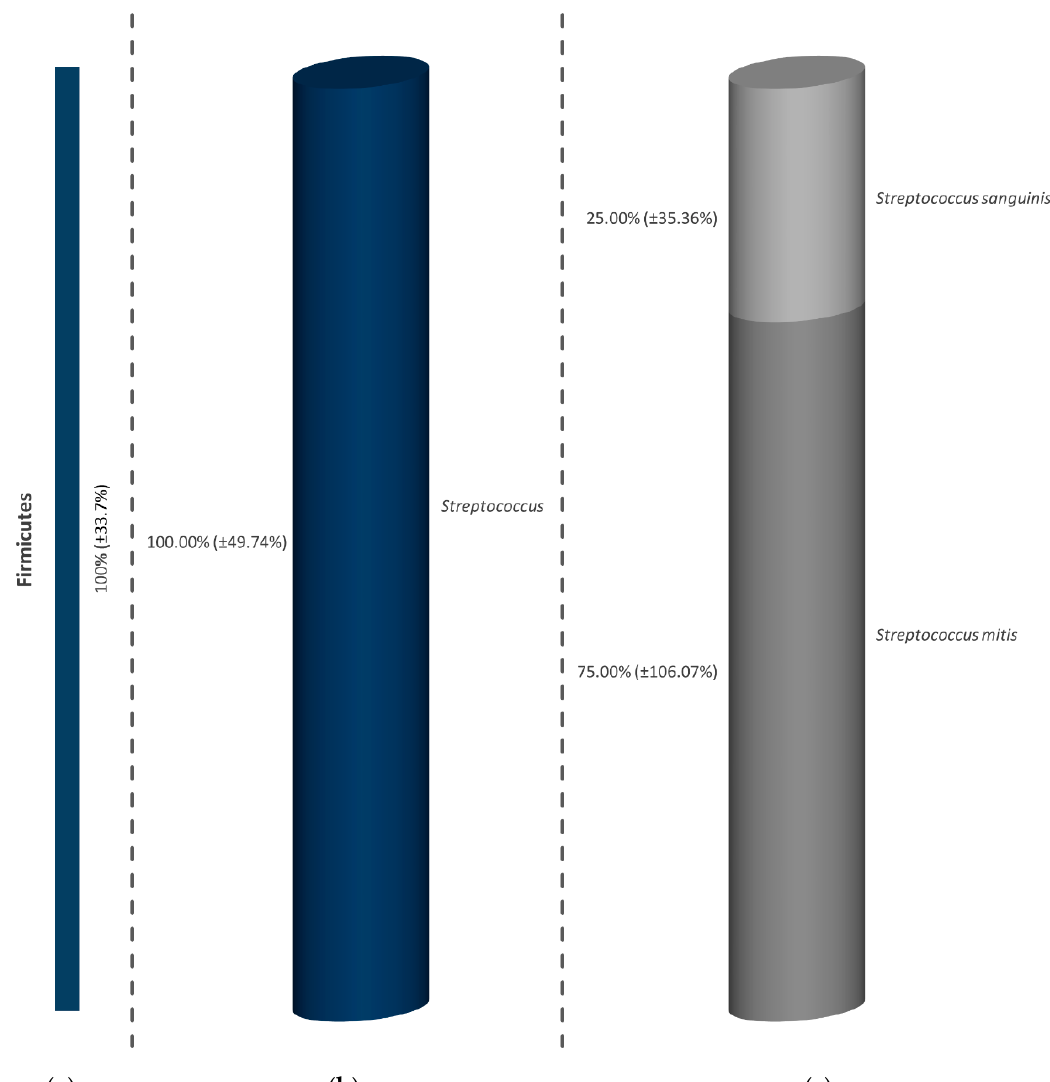
Figure 4b. With regard to the percentage distribution, Campylobacter spp. followed with 15.35% and with almost 10% Gemella spp. (9.82%) and Neisseria spp. (9.60%), which were also present in the biofilms. In addition, smaller proportions of Veillonella spp. (6.77%), Eikenella spp. (1.14%), Haemophilus spp. (0.74%), Actinomyces spp. (5.42%), Rothia spp. (4.50%), Fusobacterium spp. (2.26%), Capnocytophaga spp. (0.39%) and Prevotella spp. (0.01%) could be identified. Within the dominant genera of streptococci, S. mitis showed an especially high proportion of 82.53%. Further, proportions of S. gordonii (7.94%), S. sanguinis (6.62%) and S. oralis (2.91%) were also detected (Figure 4c). Antibiotics 2020 , 9 , x